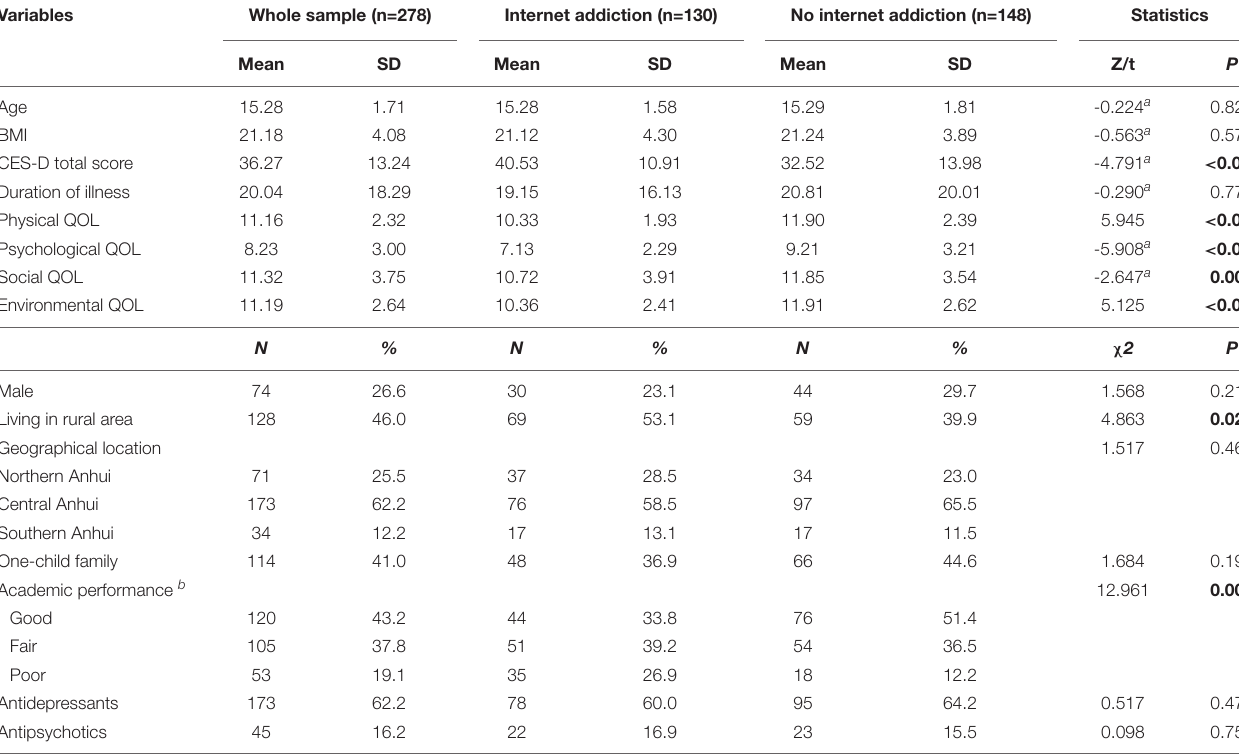
TABLE 1 | Demographic and clinical characteristics of participants with and without internet addiction symptoms Variables Whole sample (n=278) Internet addiction (n=130) No internet addiction (n=148)